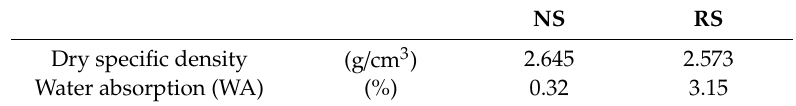
Table 1. Specific gravity and water absorption of aggregates. NS, natural sand; RS, recycled sand.